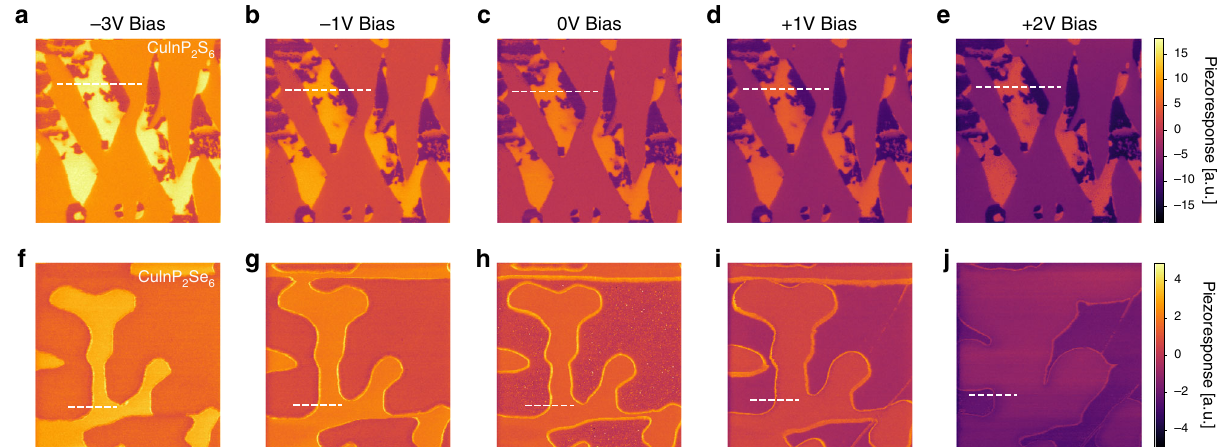
Fig. 2 Bias-dependent piezoresponse imaging of CuInP 2 S 6 and CuInP 2 Se 6 . a – e CuInP 2 S 6 imaged (image size 1.5 µ m x 1.5 μ m) at room temperature in a controlled environment and f – j CuInP 2 Se 6 imaged (image size 2.0 µ m x 2.0 μ m) at 140 K in ultrahigh vacuum. Dotted white lines indicate line pro fi le locations for Fig. 3(a, b). The bias applied to the tip is speci fi ed in the top regions. Given the propensity of CuInP 2 Se 6 toward antiferro- electric ordering ( 12 and see below), the polar and antipolar regions would correspond to ferrielectric and antiferroelectric phases, respectively.